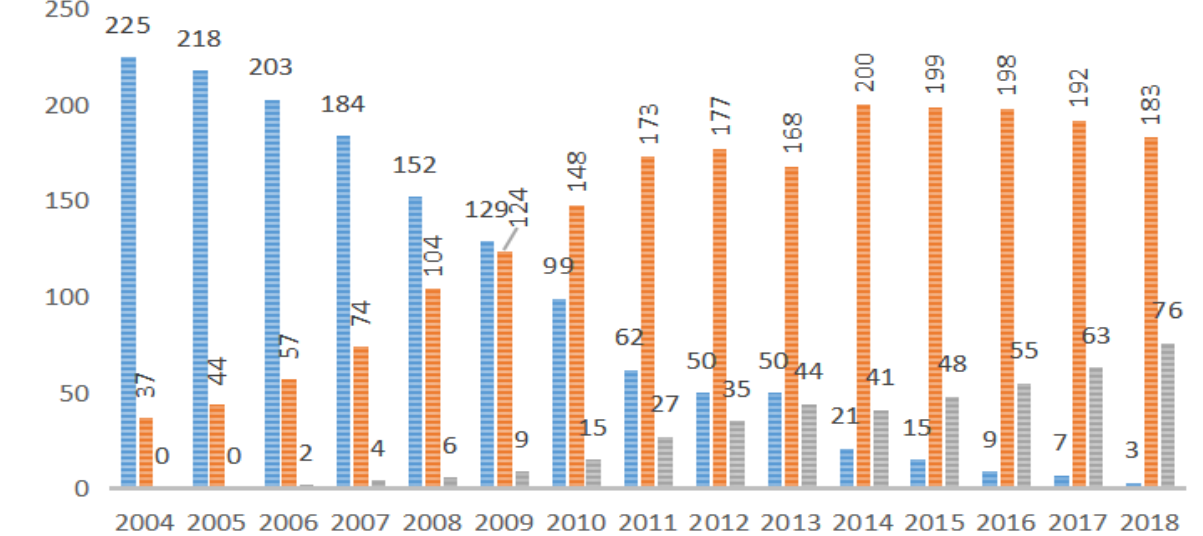
Figure 3. The number of cities in different levels of economic growth zones from 2004 to 2018.